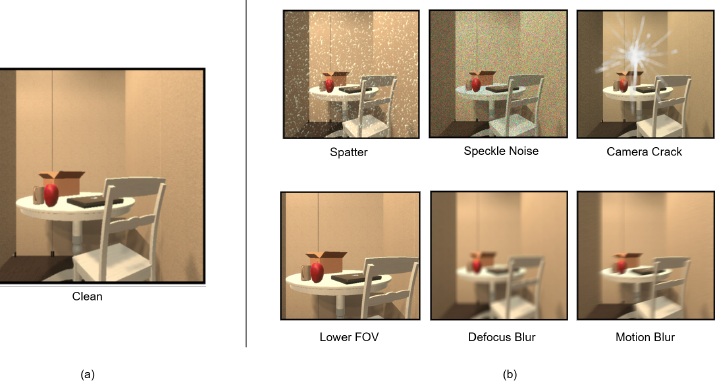
Figure 7. ( a ) The agent’s egocentric clean RGB observation. ( b ) The agent’s egocentric RGB observa- tion in the presence of visual